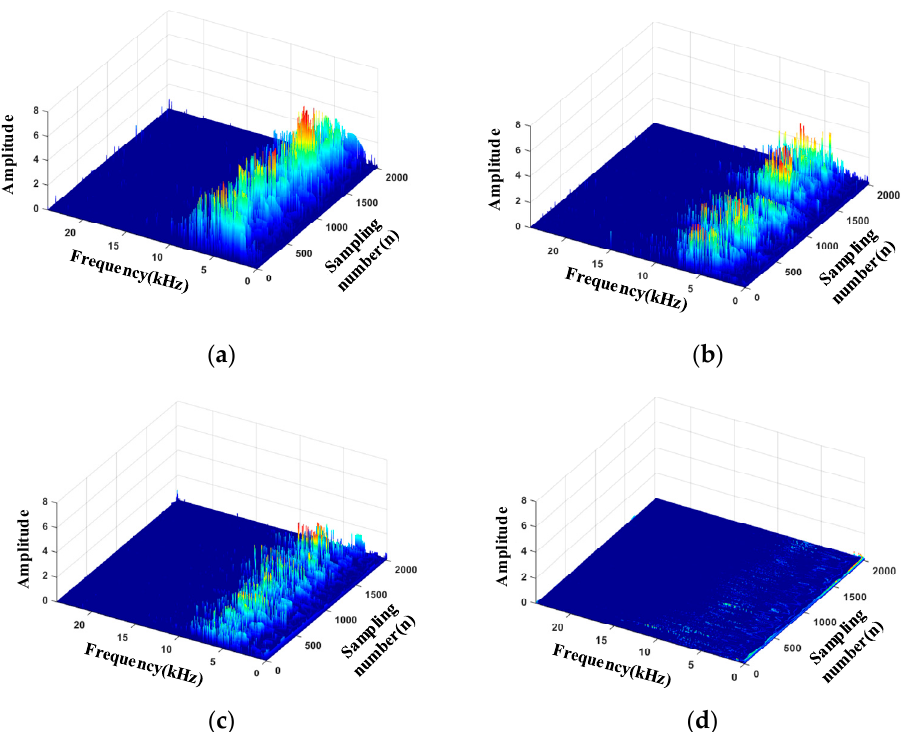
Figure 14. Three-dimensional (3D) time-frequency diagram of each leak state in DN20. (a) 0.30 MPa; (b) 0.25 MPa; (c) 0.20 MPa; (d) Not leak